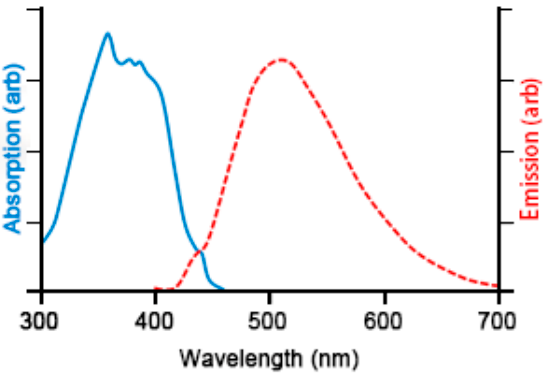
Figure 1. Illustrative chart of excitation and emission spectra of 3-hydroxy-DL-kynurenine (3-OHK). Adapted from [5].